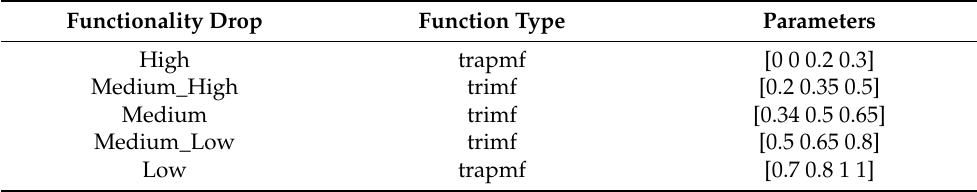
Table 6. Functionality drop membership functions with five